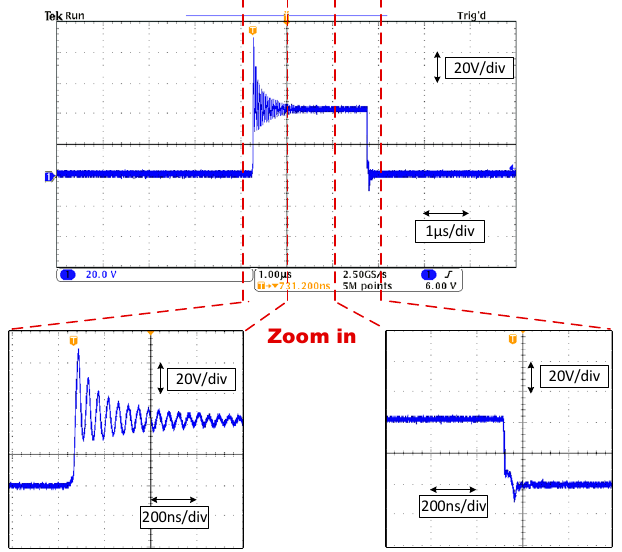
Figure 3. The experimental voltage waveform of switch measured by oscilloscope.